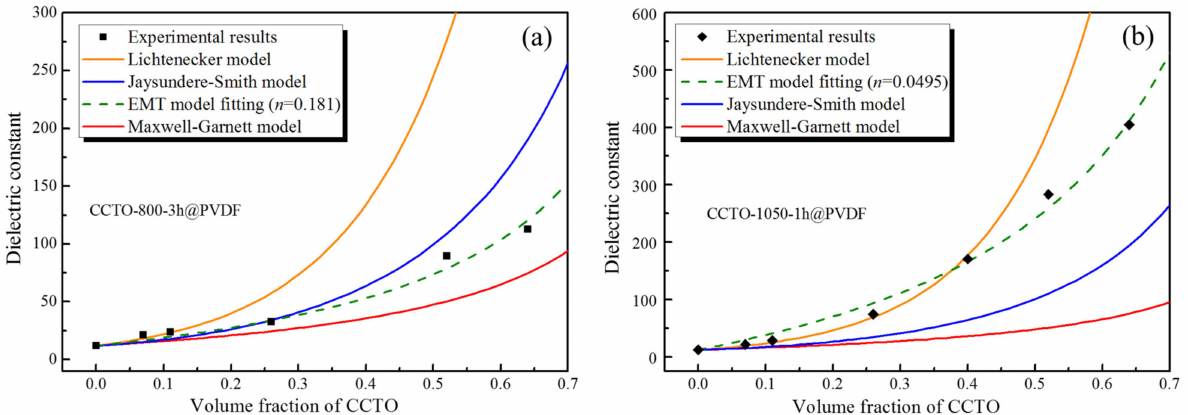
Figure 11. Various theoretical predictions and experimental results of the dielectric constant of ( a ) CCTO-800-3 h@PVDF and ( b ) CCTO-1050-1 h@PVDF composites at different volume fractions of filler at 1